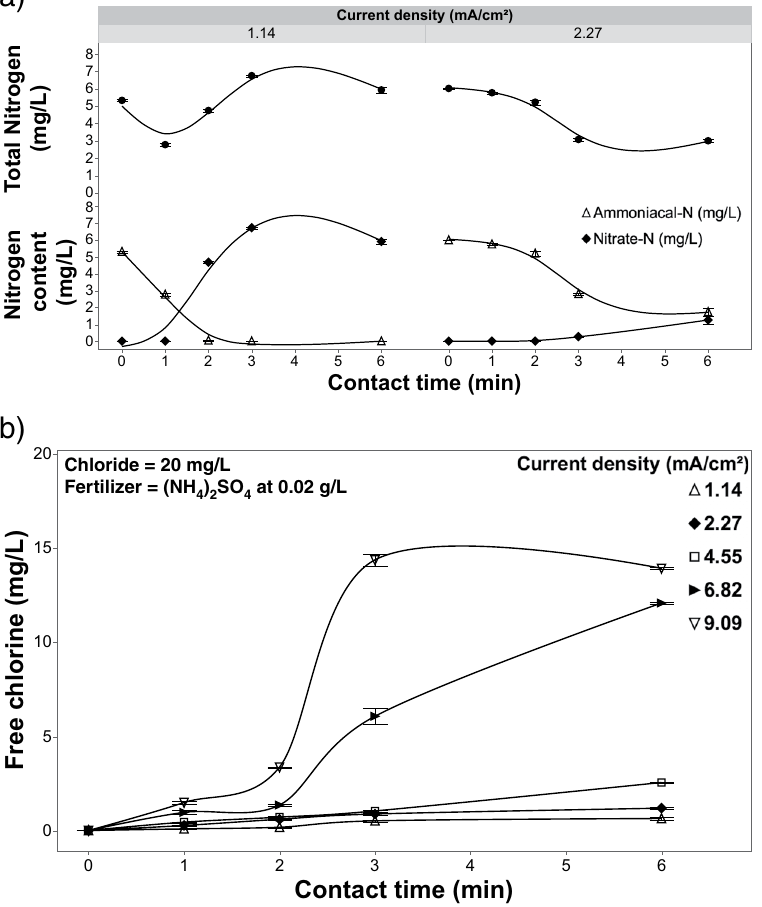
Figure 15. Nitrogen and free chlorine dynamics at variable contact times and current densities. ( a ) Nitrogen dynamics as a function of current density (1.14 & 2.27 mA/cm 2 ) and contact time of the solution containing (NH 4 ) 2 SO 4 as the supporting electrolyte (relative to 0.05 g/L of 20-8-20 Plant Prod fertilizer) and 20 mg/L of chloride. ( b ) effluent free chlorine concentration as a function of current density and contact time. Error bars are ± SEM, N =